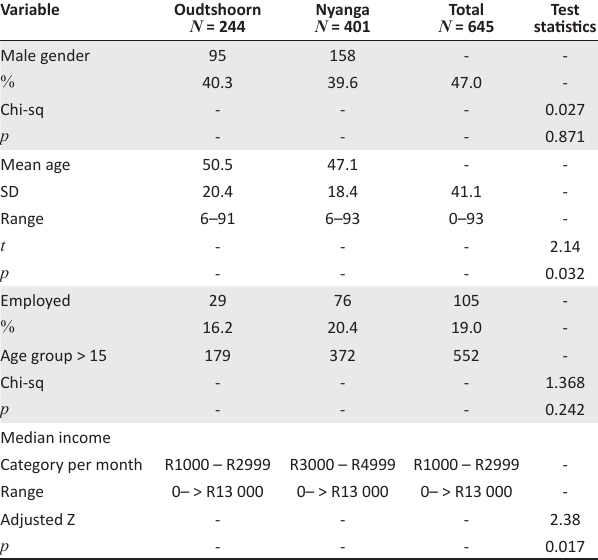
TABLE 4: Demographics of people screening positive for disability across the two